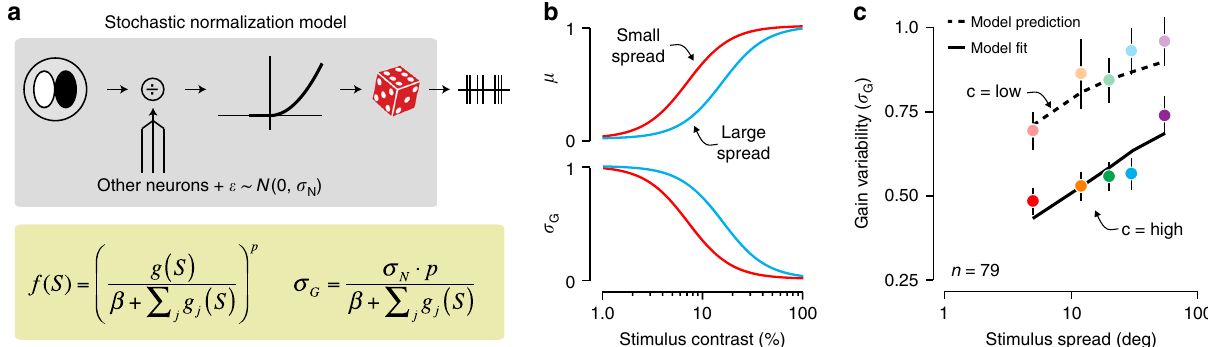
Fig. 5 A stochastic normalization model accounts for the effects of stimulus uncertainty on gain variability. a Top: Model diagram. The response of a spatial fi lter is divided by the summed activity of neighboring units, an additive constant, and a noise source. The normalized signal is passed through a nonlinearity to obtain a fi ring rate which serves as input for a Poisson process. Bottom: equations for the mean response and gain variability under this model. b Mean response (top) and gain variability (bottom) as a function of stimulus contrast for a narrowband (red) and a broadband (blue) stimulus. c Measured gain variability compared with the prediction of the stochastic normalization model. The model was fi t to the average gain variability across all neurons measured for high contrast stimuli (opaque points), but not to the low-contrast conditions (transparent points). Error bars indicate ± 1